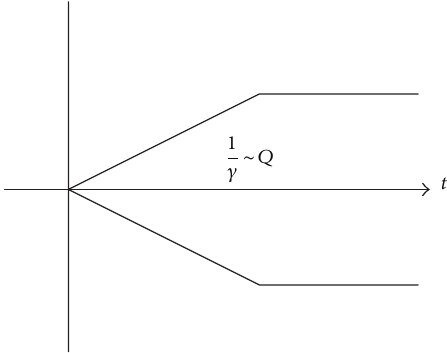
(𝑡) appearing in the last graph. out